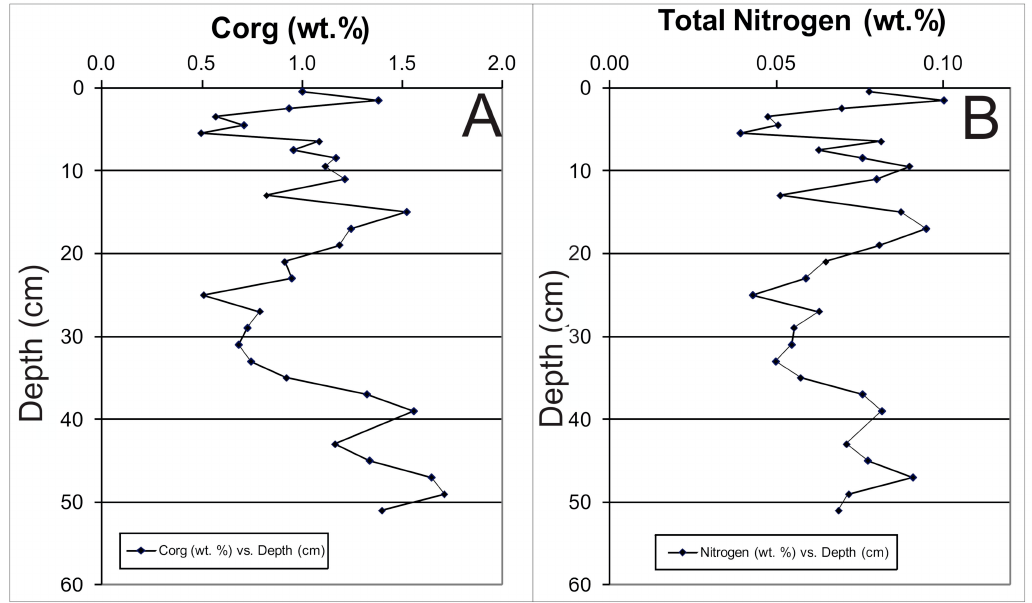
Figure 3. Downcore variations in Organic Carbon (C org ; A ) and Total Nitrogen ( B ) for bulk sediment samples. Both Organic carbon and Total Nitrogen concentrations show similar trends with concentration highs at the base of the cored sediment (50 cm depth) which then decrease to approximately 30 cm core depth. Concentrations of C org and TN both increase from 30 cm to 18 cm and then fluctuate towards the sediment-water interface (0 cm depth).